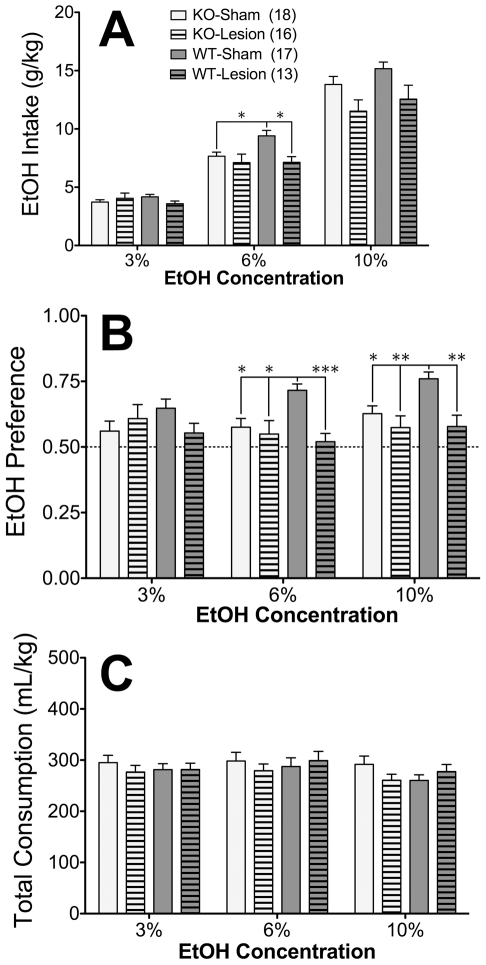
Effects of EWcp lesion on 2-BC EtOH drinking in Ucn1 KO and WT mice.(A) EtOH Intake (g/kg), (B) EtOH Preference, and (C) Total Fluid Consumption (mL/kg) of male Ucn1 KO and WT mice following either sham surgery or EWcp lesion. Asterisks indicate significant difference from the respective WT-Sham group (*p≤.005, **p≤.001, ***p<.0001). Numbers in parentheses indicate group sizes. The same animals contributed to panels A, B, and C.